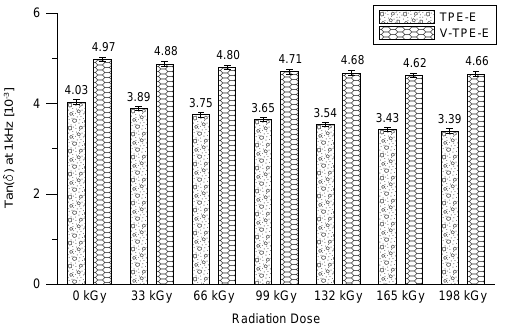
Figure 9. Loss factor measured at 1